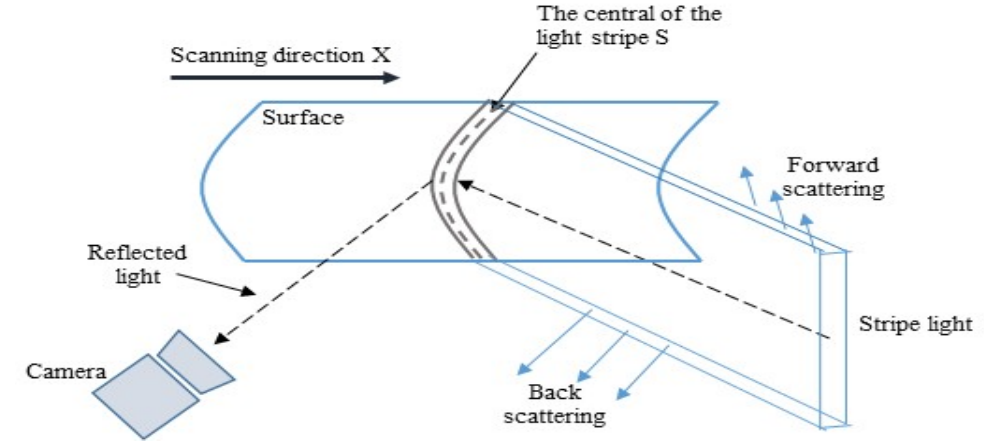
Figure 1. Typical structured lighting technique.